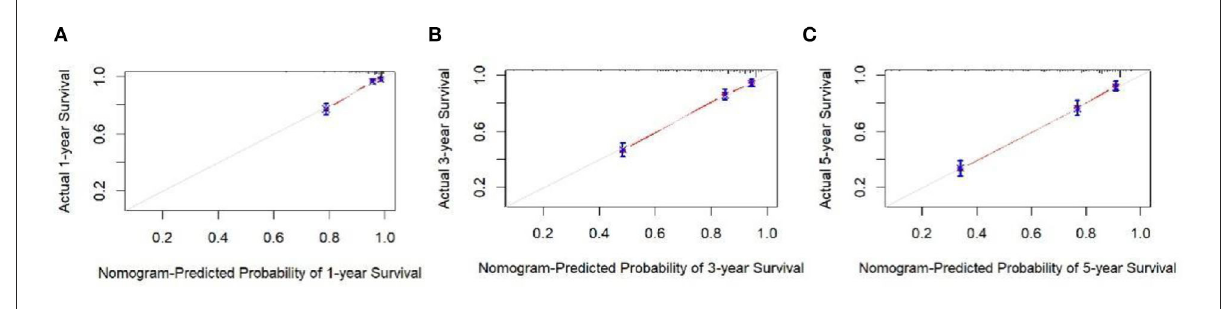
FIGURE4 Appendix cancer outcome 1-, 3-, and 5-year calibration curves of validation set patients. (A–C) Are calibration curves for validation sets 1, 3, and 5.